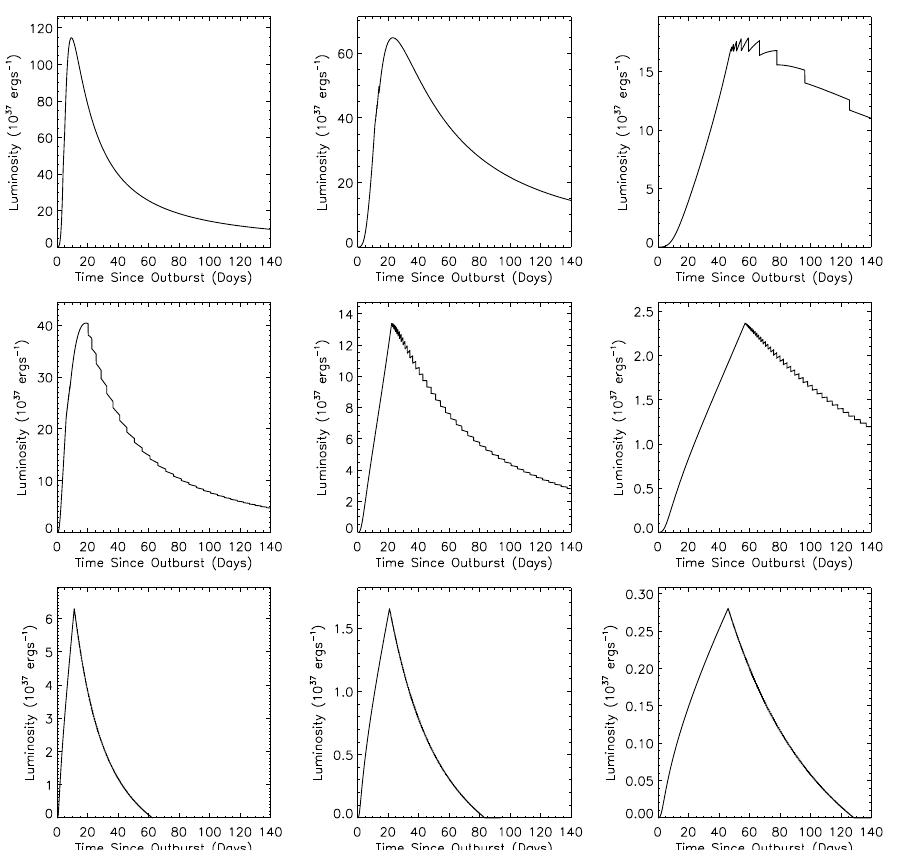
Fig. 3. Luminosity evolution over the (cid:12)rst 140 days predicted by our simple model for an assumed Mira mass-loss rate of 10 − 5 M ⊙ yr − 1 . The top, middle and bottom rows are the results for nova ejecta masses of 10 − 5 , 10 − 6 and 10 − 7 M ⊙ , respectively, and the left, middle and right columns are for binary separation of 10, 20 and 50 R ⊙ . The steplike features in some of the plots are artefacts of our simple model { if the post-shock temperature of a given region is less than 10 6 K, we assume it no longer emits X-rays. Therefore, discontinuities in the luminosity arise as material is strongly